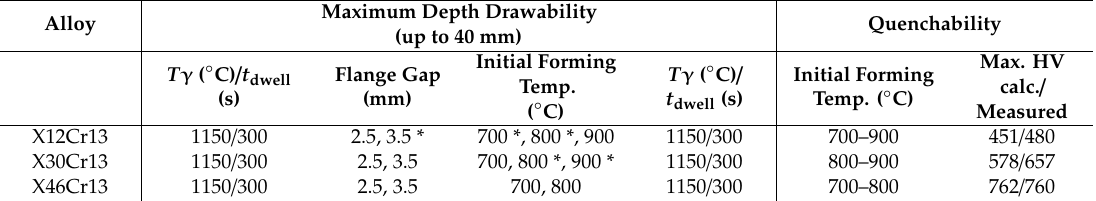
Table 5. Optimum deep drawing parameters for the investigated MSS alloys. This summary considered only the results with a β = 1.7 (Blank Ø = 170 mm), which showed the best results.